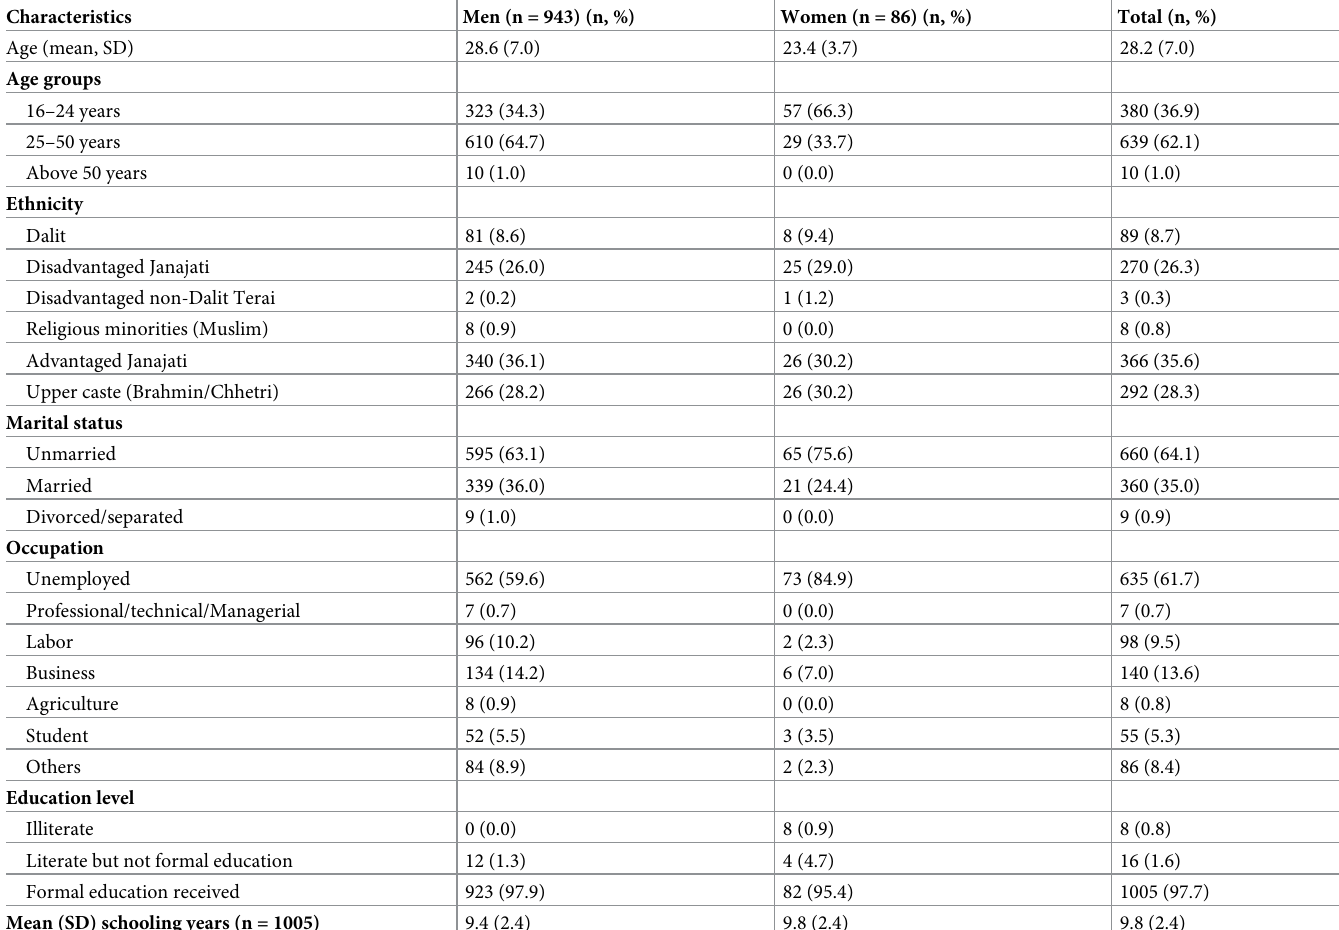
Table 1. Socio-demographic characteristics of participants by